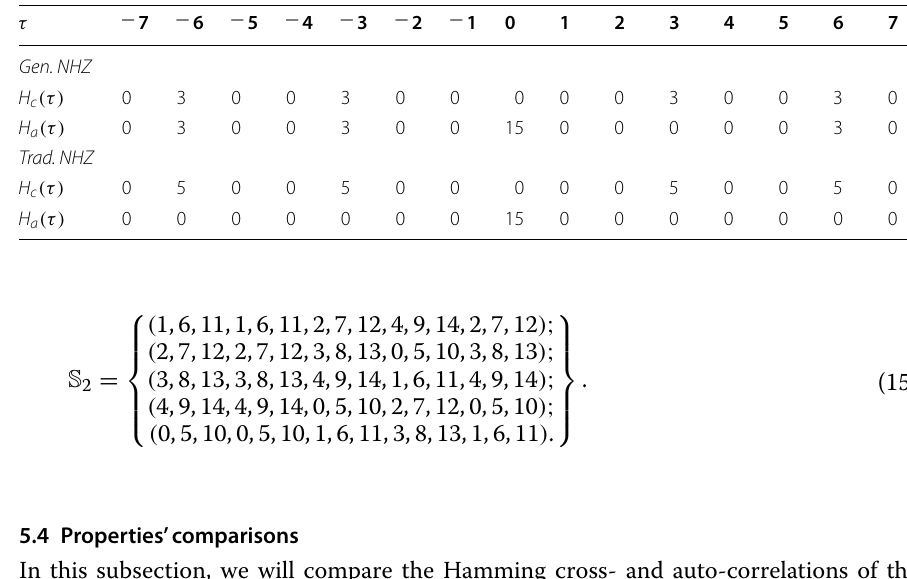
Table 2 The Hamming correlations of the NHZ hopping patterns with Z